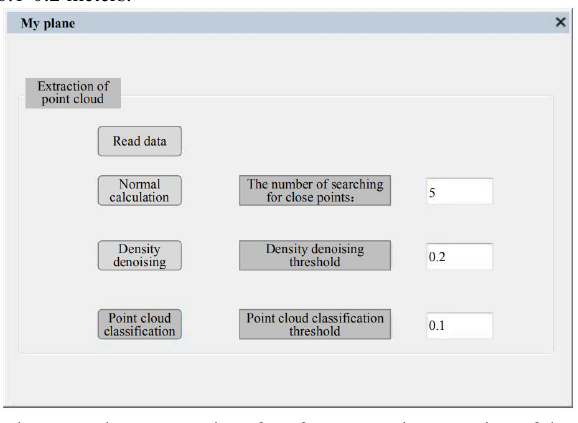
Figure 5. The program interface for automatic extraction of the accident vehicle point cloud After a number of threshold comparisons, the extraction efficiency of the experimental data with the elevation difference threshold of 0.2m is the best. The point cloud of the accident vehicle is shown in figure 6(a). From the classification effect map,due to the height of road ridge is generally not higher than 0.3m (Nie, 2012), thus the road ridge is also divided into the accident vehicle points, and there are very few grounds points which are divided into the accident vehicle points. And so that the road ridge and the wrong point cloud. After